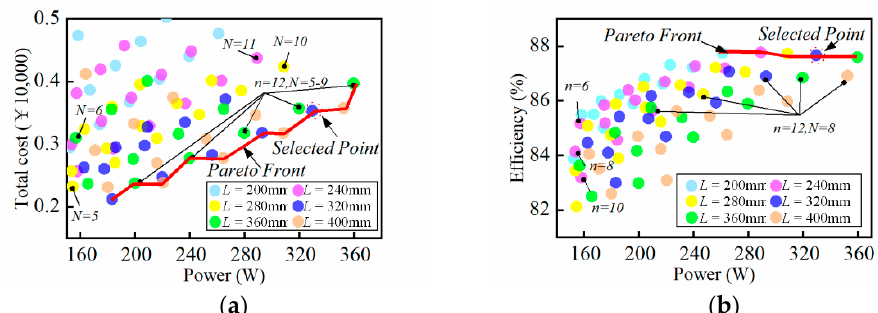
Figure 7. Multi–objective optimizing results of DWPT system: ( a ) power vs. total cost; ( b ) power vs efficiency with different transmitter coil construction.